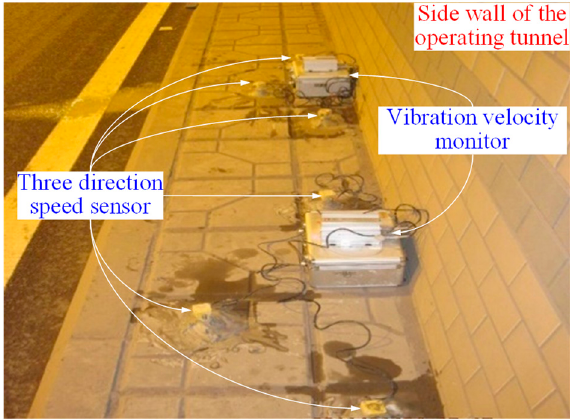
Figure 2. Vibration velocity monitoring points in operating tunnel above excavation face.